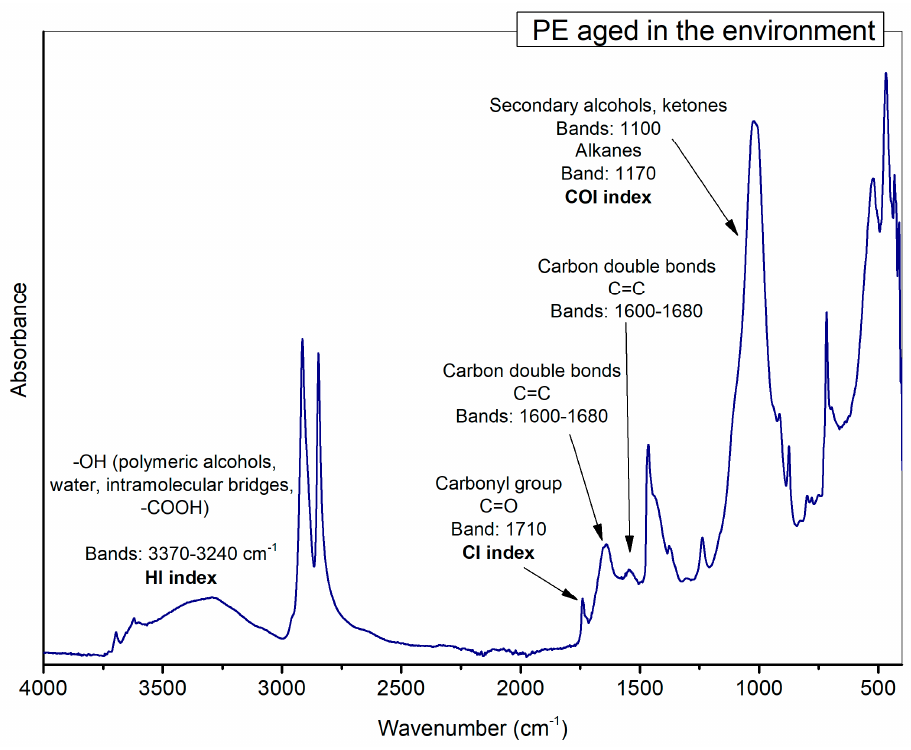
Figure 7. Example of a spectrum of naturally weathered PE with the appearance of new functional groups due to degradation process.